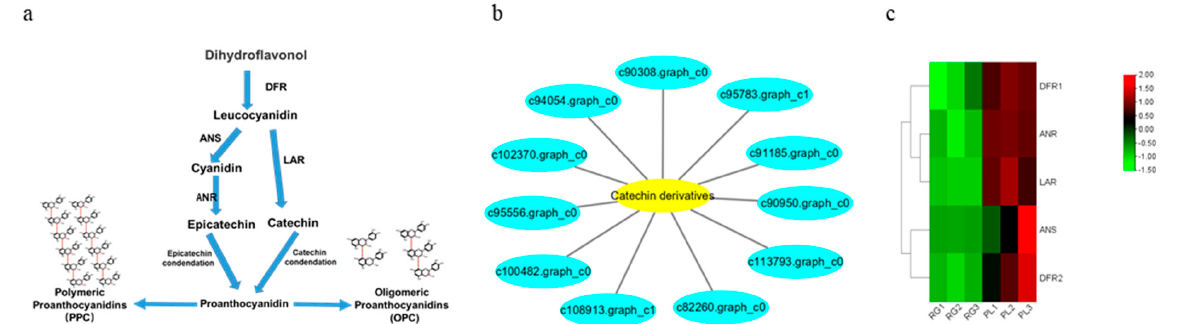
Figure 7. Analysis of key gene differences in the synthetic pathway of PA in T. hemsleyanum . ( a ) The synthetic pathway diagram of PA ubiquitous in plants; ( b ) The genes network related to the metabolism of catechin and its derivatives; ( c ) Cluster analysis of DEGs related to PA. Genes with a high expression in the RG vs. PL are shown in red and green, respectively.